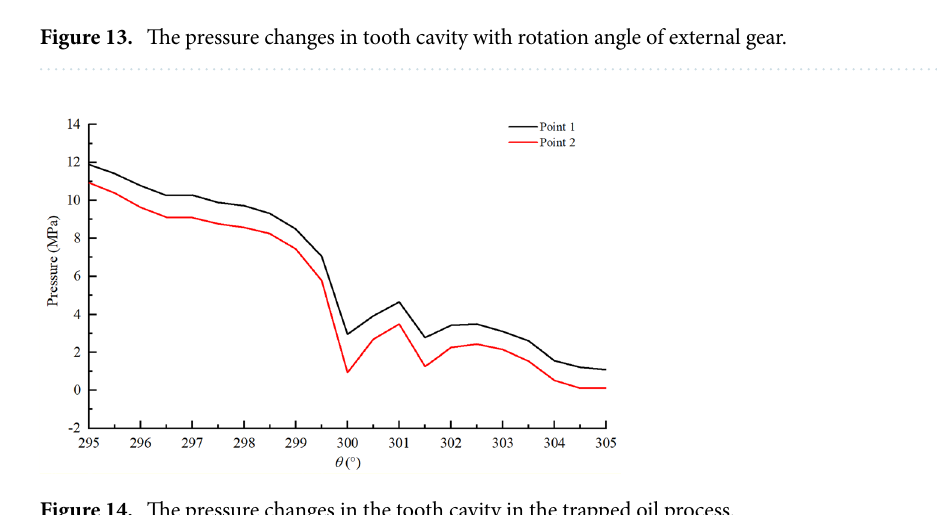
Figure 14. The pressure changes in the tooth cavity in the trapped oil